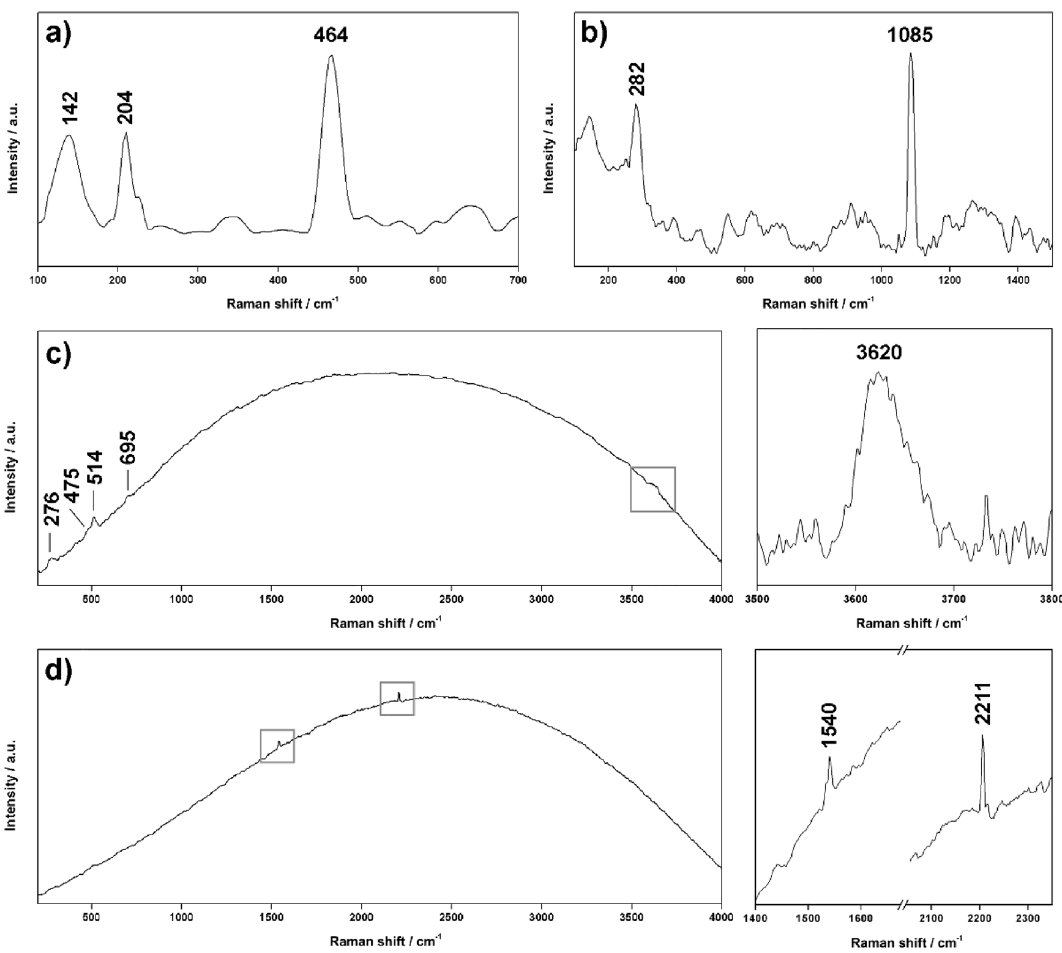
Figure 4. Characteristic Raman spectra of organic compounds collected in the laboratory by the RLS ExoMars Simulator (532 nm). All spectra have been smoothed using dedicated IDAT/SpectPro